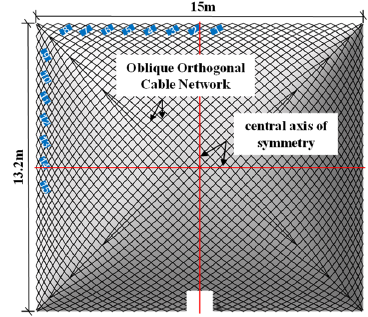
Figure 21. Sensor number.